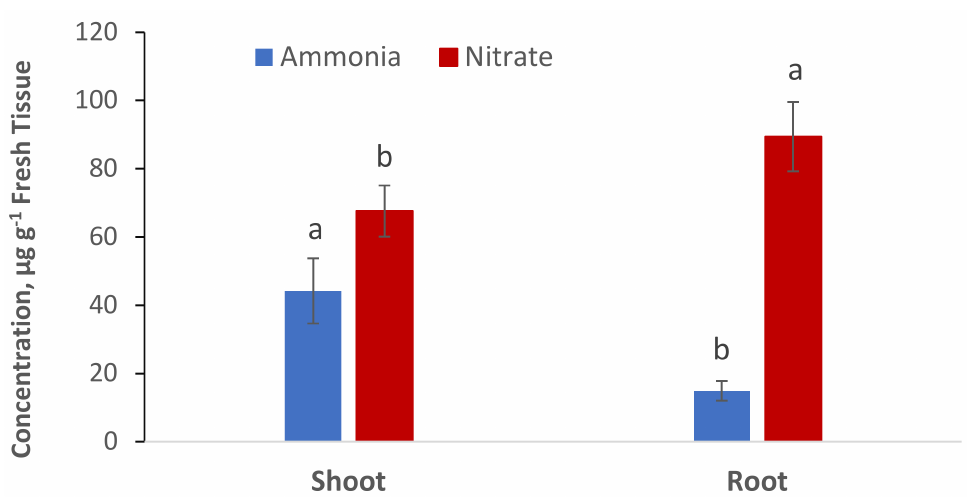
Figure 5. Overall concentrations of ammonia and nitrates in turnips shoot and root plants, regardless of turnips variety. Statistical comparisons were carried- out between the shoot and root using analysis of variance (ANOVA). Standard errors having different letter indicate significant differences ( p ≤ 0.05) using Duncan’s multiple range test for mean comparisons.